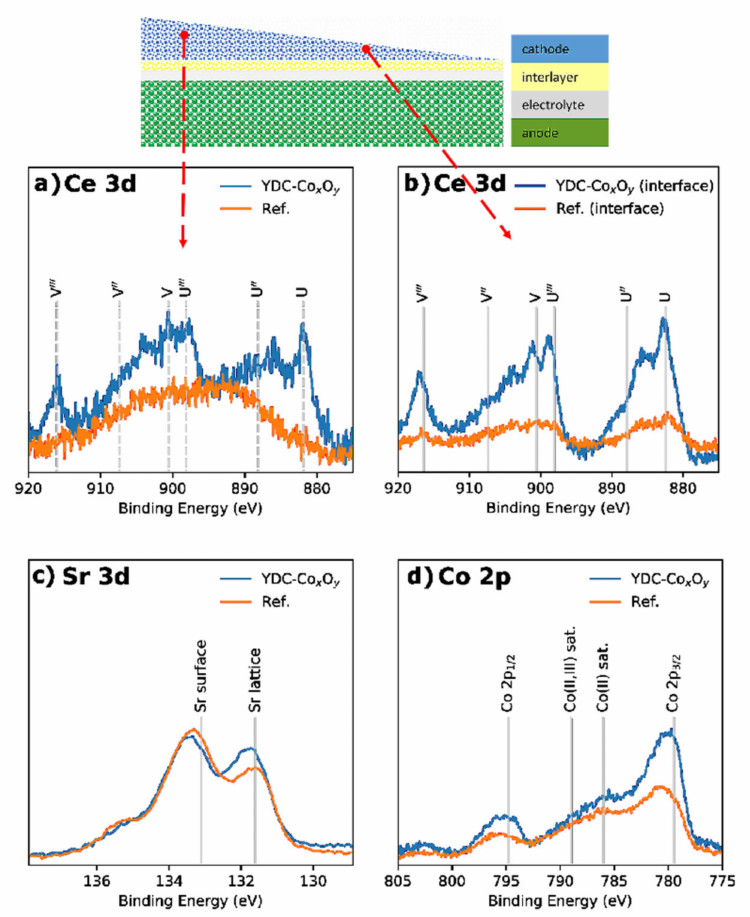
Figure 8. XPS spectra of Ce 3d ( a ), Sr 3d ( c ) and Co 2p ( d ) core levels of the LSCF bulk area and Ce 3d core level ( b ) of the near-interface areas for the reference and YDC-Co x O y infiltrated